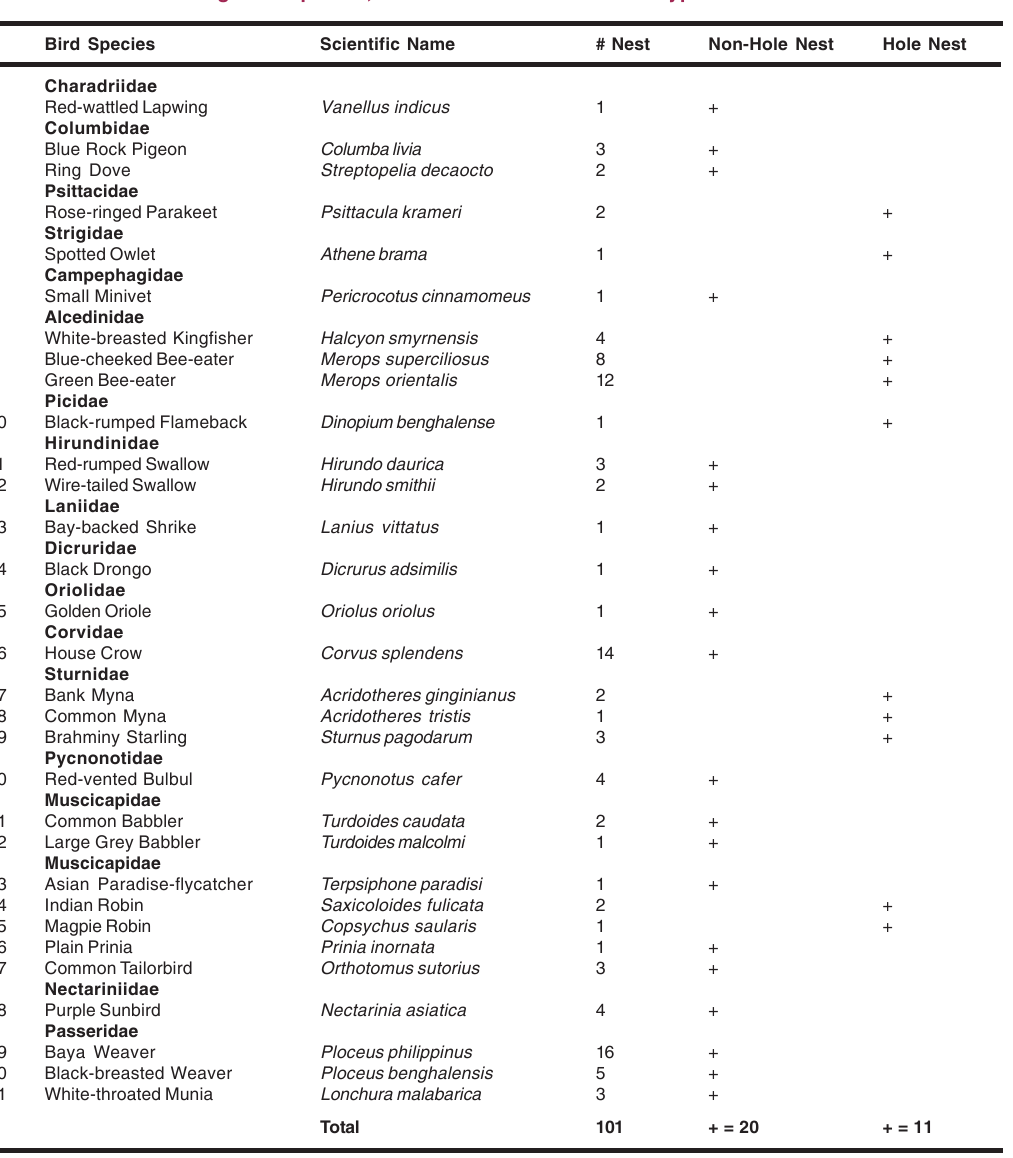
Table 3. List of nesting bird species, number of nests and nest